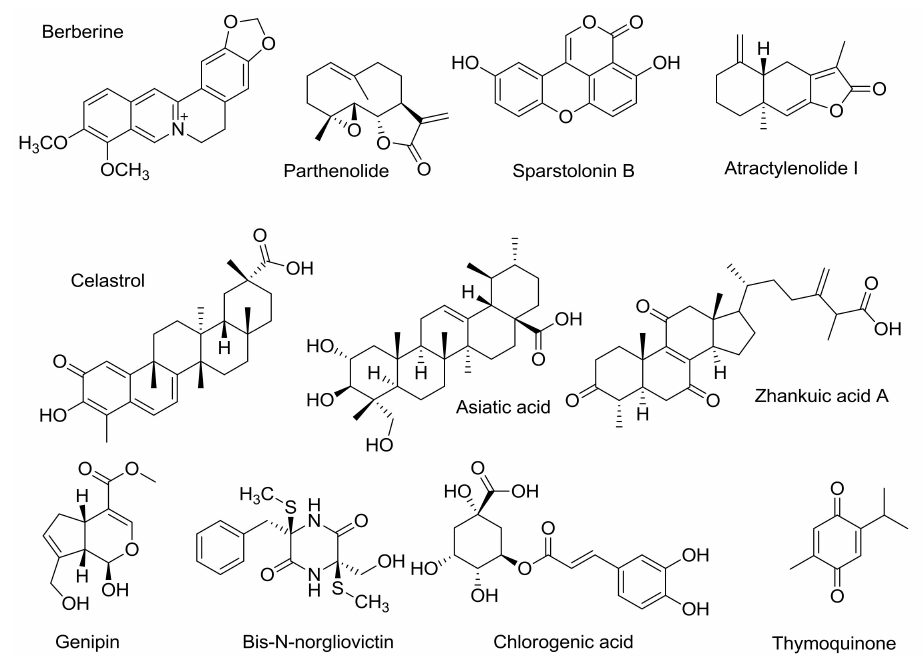
Figure 2. Natural compounds with TLR4-antagonistic properties, tested in vivo on animal models of